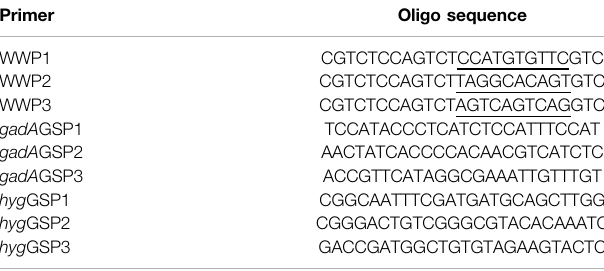
TABLE 1 | Primers used in this study. TABLE 2 | Pairing of the WWP permutation with the GSP set in nested PCRs. Round of